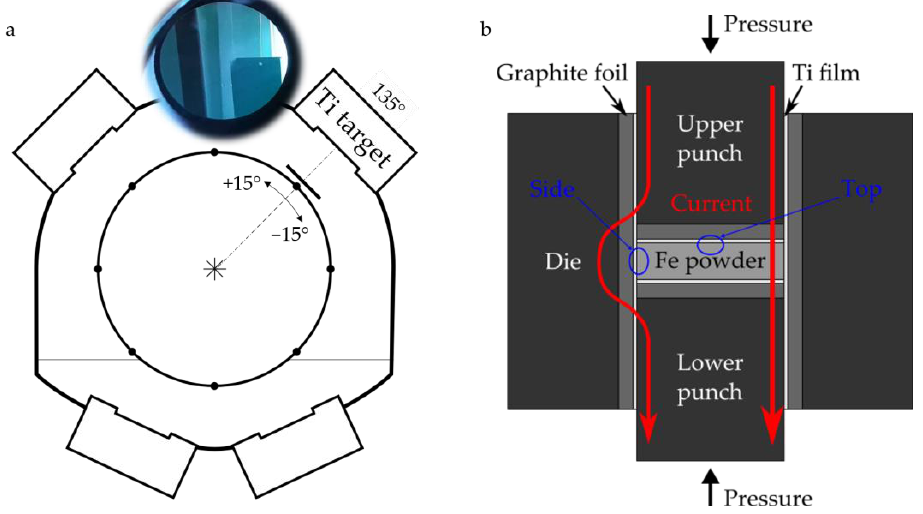
Figure 1. Schematic representations of ( a ) PVD and ( b ) SPS devices. Three coating thicknesses were obtained: 0.5, 1.1 and 1.5 µm (±0.1). In all cases, Ti coating is formed by pyramid-shaped grains and covers perfectly the graphite foil (see Supplementary Materials, Figure S2).